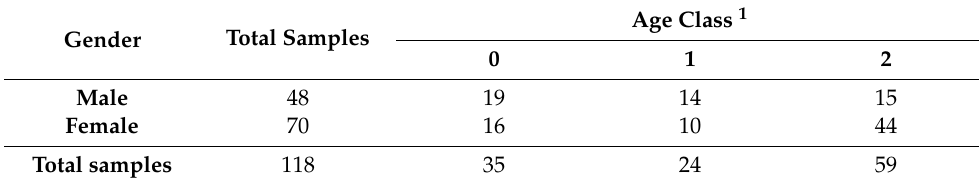
Table 5. Characteristics of the red deer sampled divided by gender and age